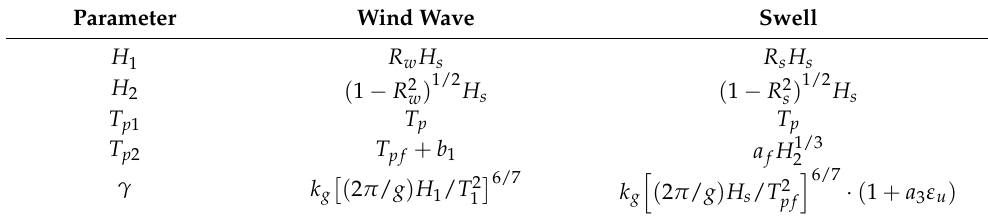
Table 1. Parameter calculation formula under different waveforms. Parameter Wind